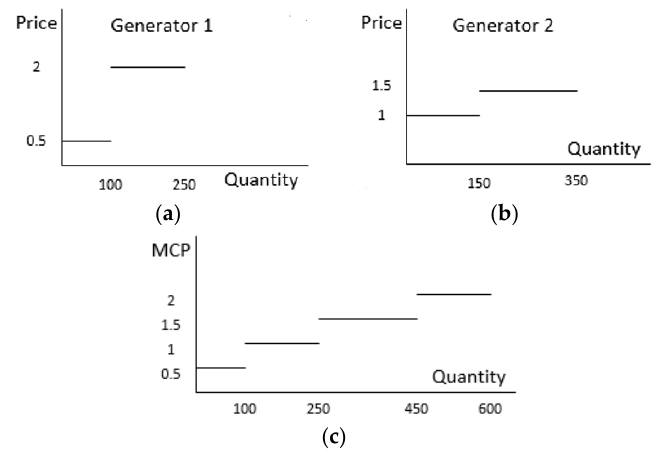
Figure 2. The process of proposed mechanism.